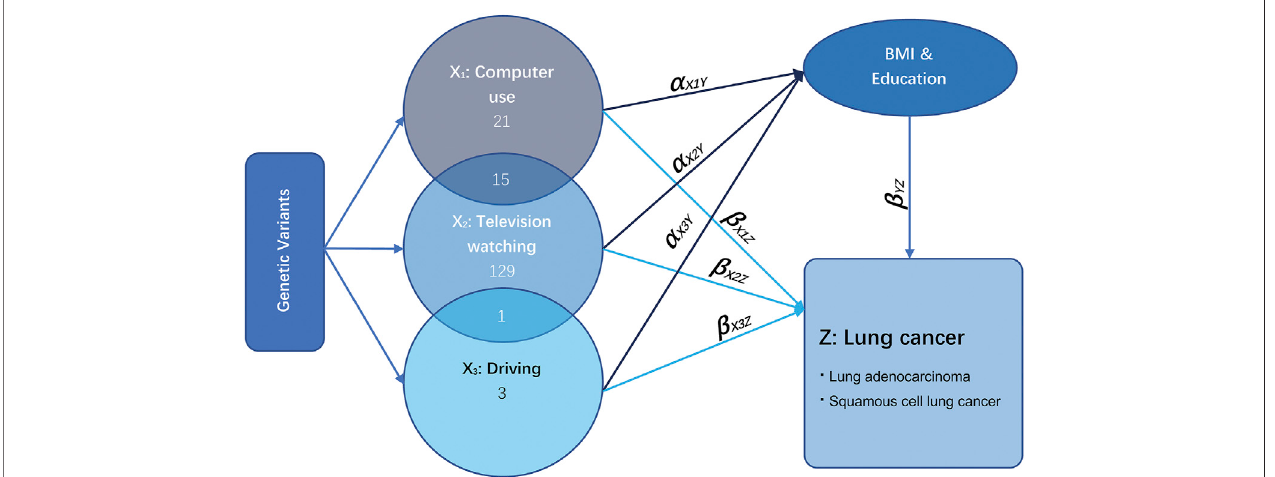
FIGURE1| IllustrativediagramofmultivariableMendelianrandomizationassumptions.Takingtheexposuretelevisionwatching(X 2 )asanexample,thedirecteffect of television watching on lung cancer is the effect television watching has on lung cancer not via any other exposure variables, which is equal to β X2Z . The total effect of television watching on lung cancer is the effect of television watching on lung cancer directly plus the effect of television watching on lung cancer via education and BMI, which is equal to β X2Z + α X2Y β YZ